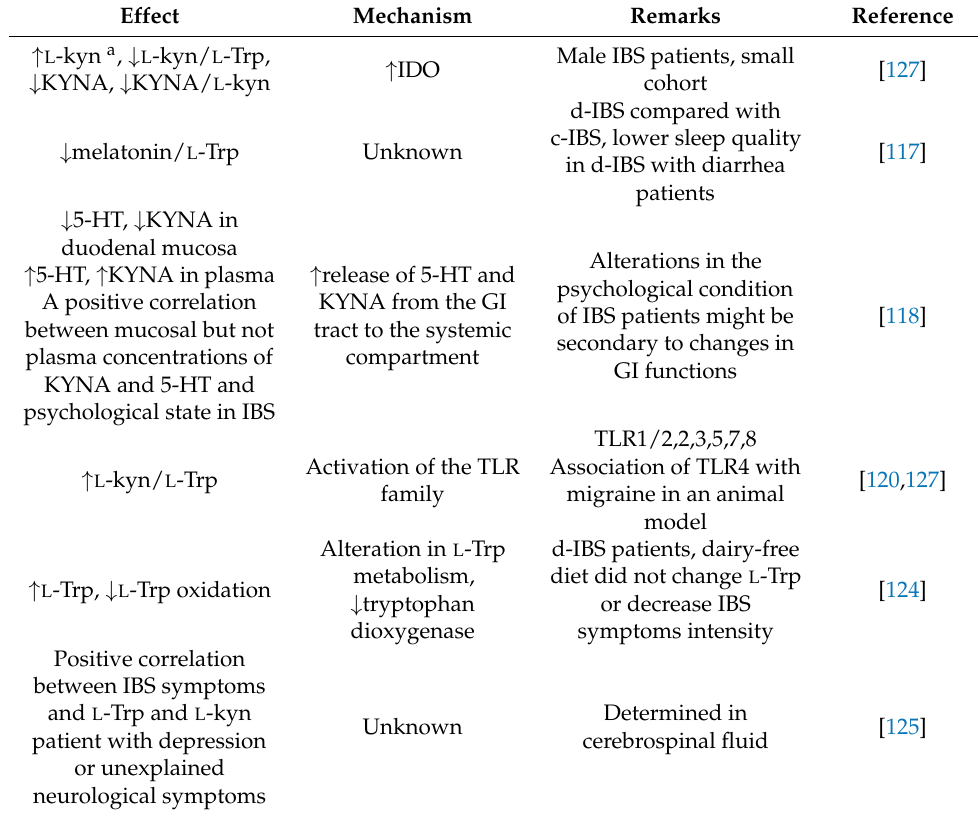
Table 1. Changes in the metabolites of the kynurenine pathway of tryptophan metabolism and associated effects in irritable bowel syndrome